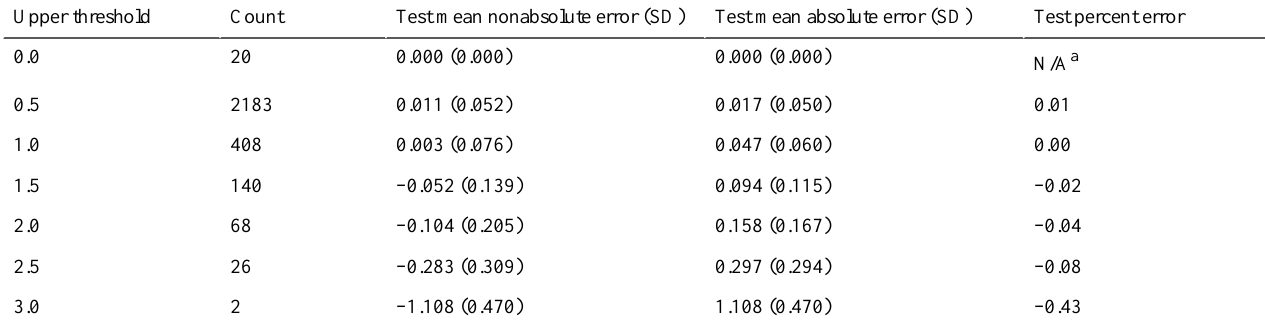
Table 9. Test errors and median percent errors of label bins of size 0.5 for the in-distribution validation method.